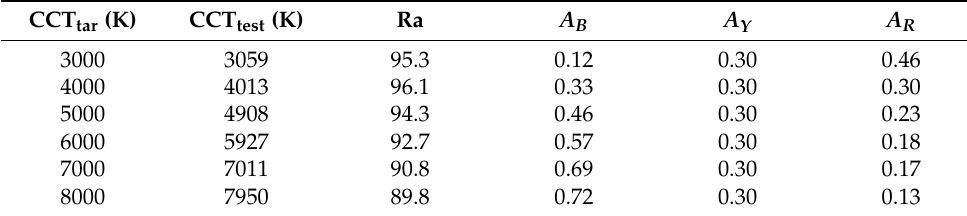
Table 2. Calculation parameters of spectral optimization using method I.